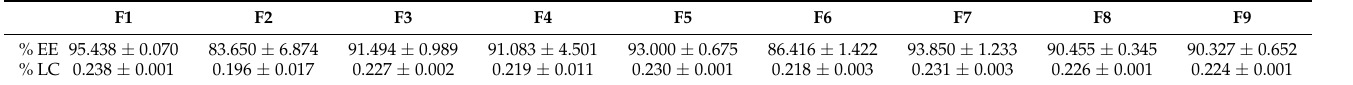
Table 6. Encapsulation efficiency and loading capacity of the TA into